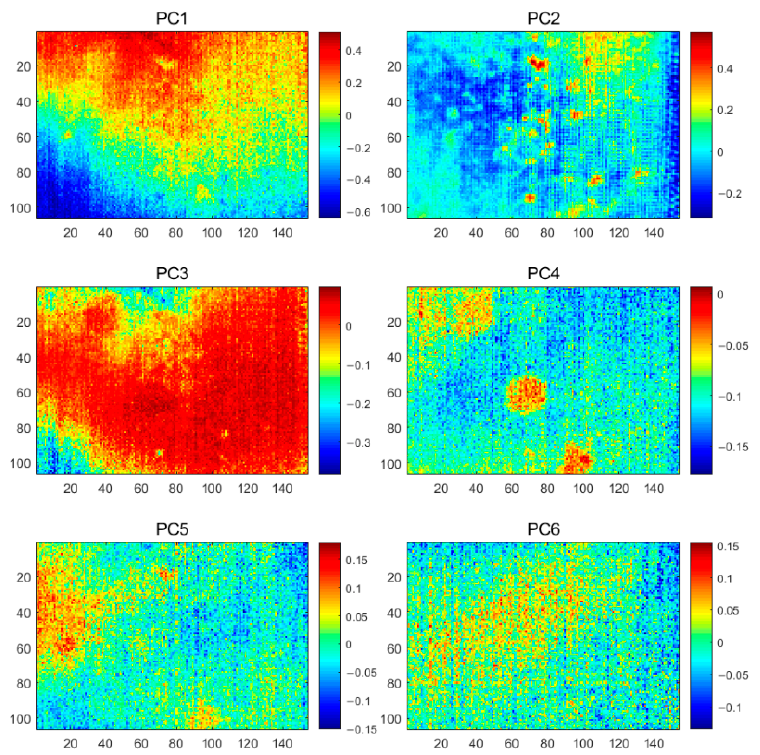
Figure 9. The KPCT analysis results of the CFRP specimen 1.